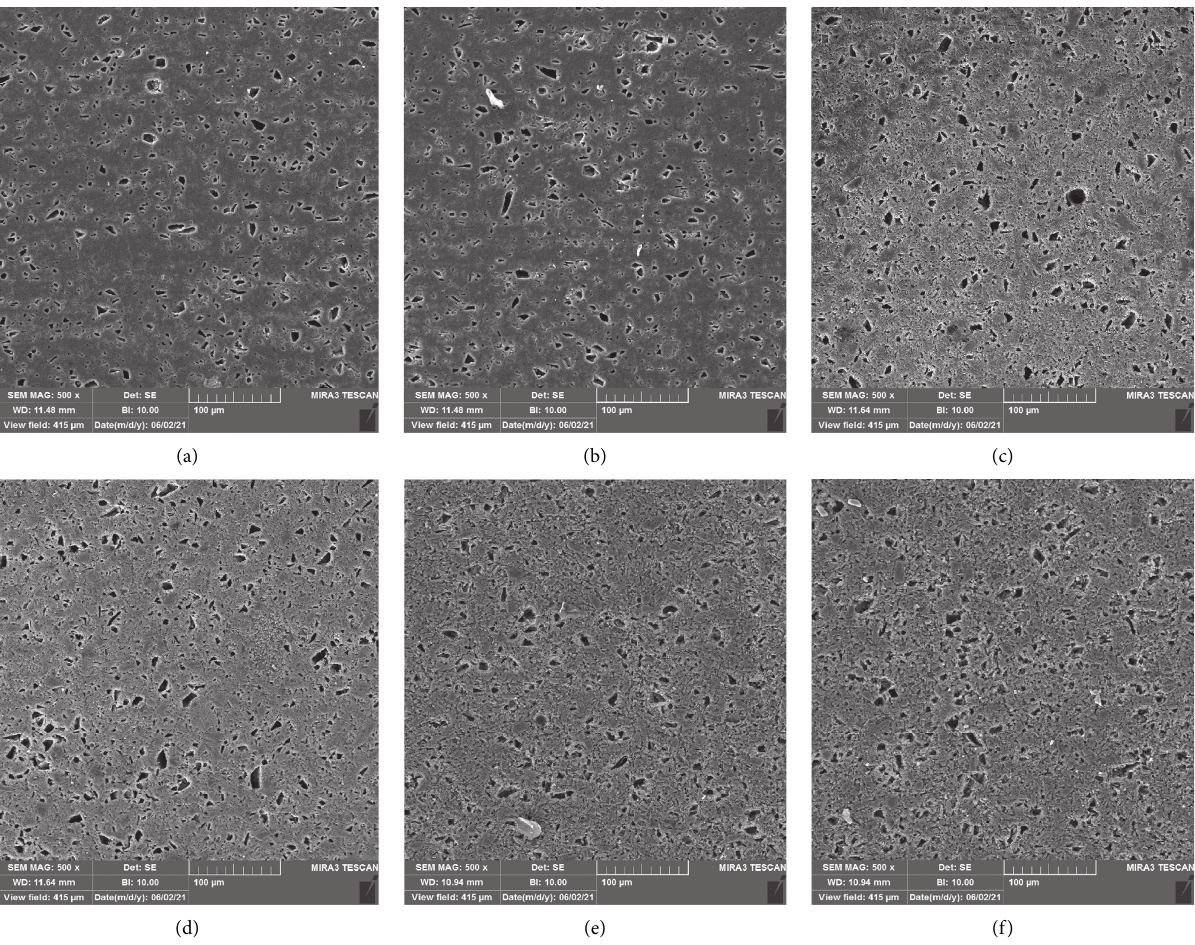
Figure 2: Scanning electron microscope photomicrographs of Vitablocs Mark II (a) before immersion and after immersion in (b) saliva, (c) acetic acid, (d) gastric acid, (e) fluoride and acetic acid, and (f) fluoride and gastric acid 4 (500X